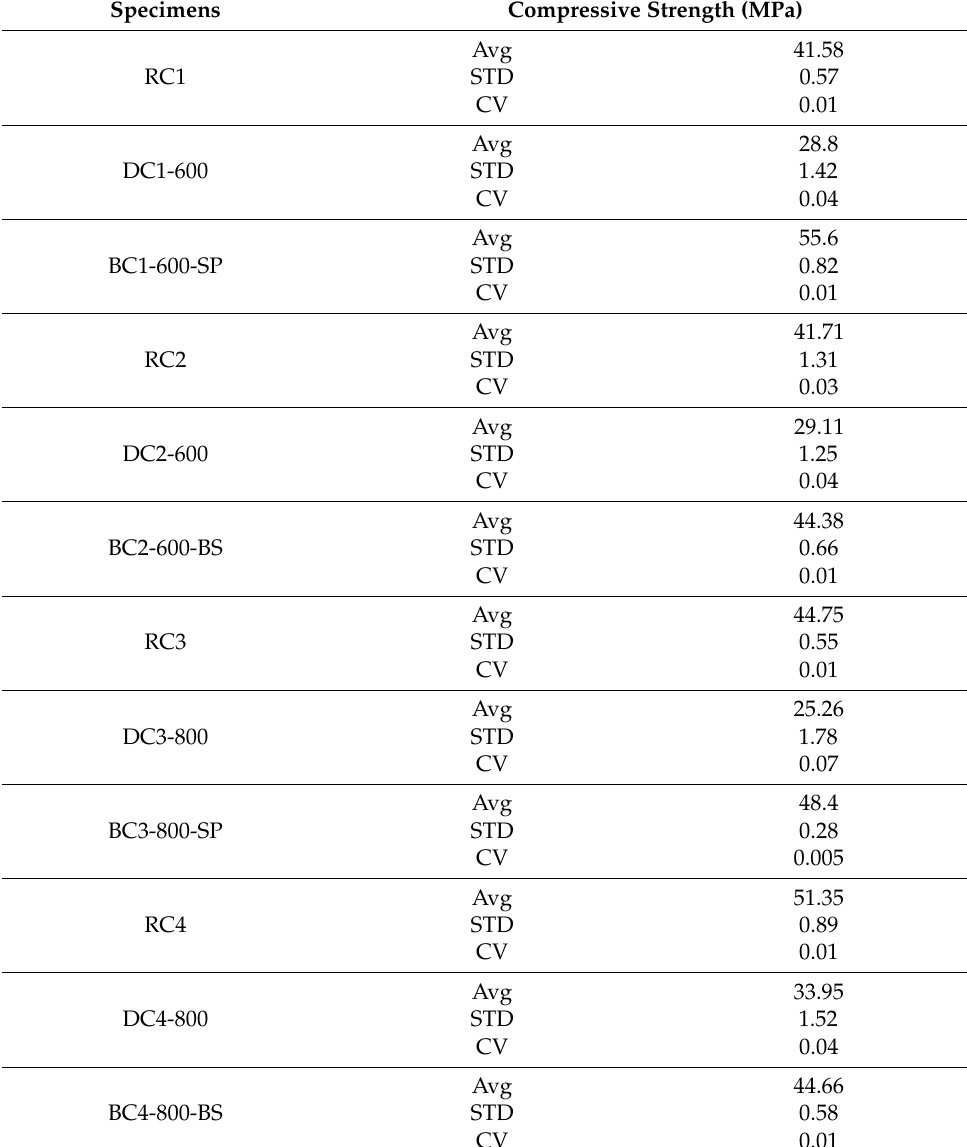
Table 3. Results of compressive